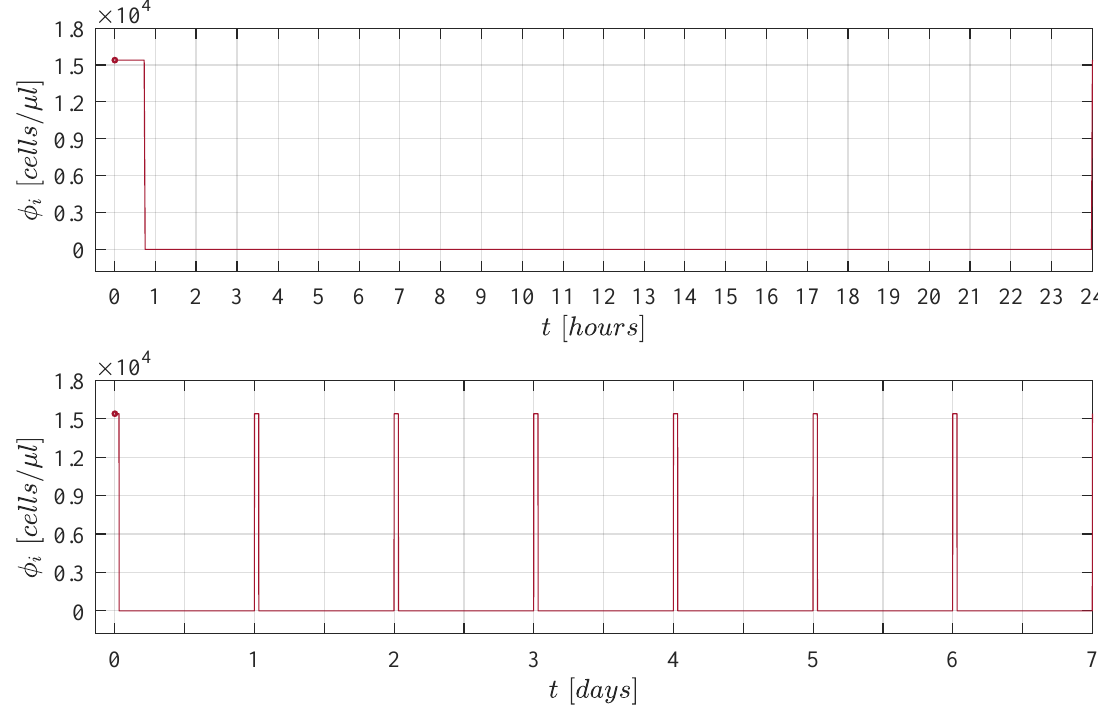
Figure 2. Administration protocol for the immunotherapy treatment. Characteristics are as follows: amplitude of φ i = 15,396 cells/ µ L and a duty cycle of 45min/day. Complete CML cancer cells eradication was achieved by means of this strategy for three considered initial non-solid tumour sizes given by C ( 0 ) = 1